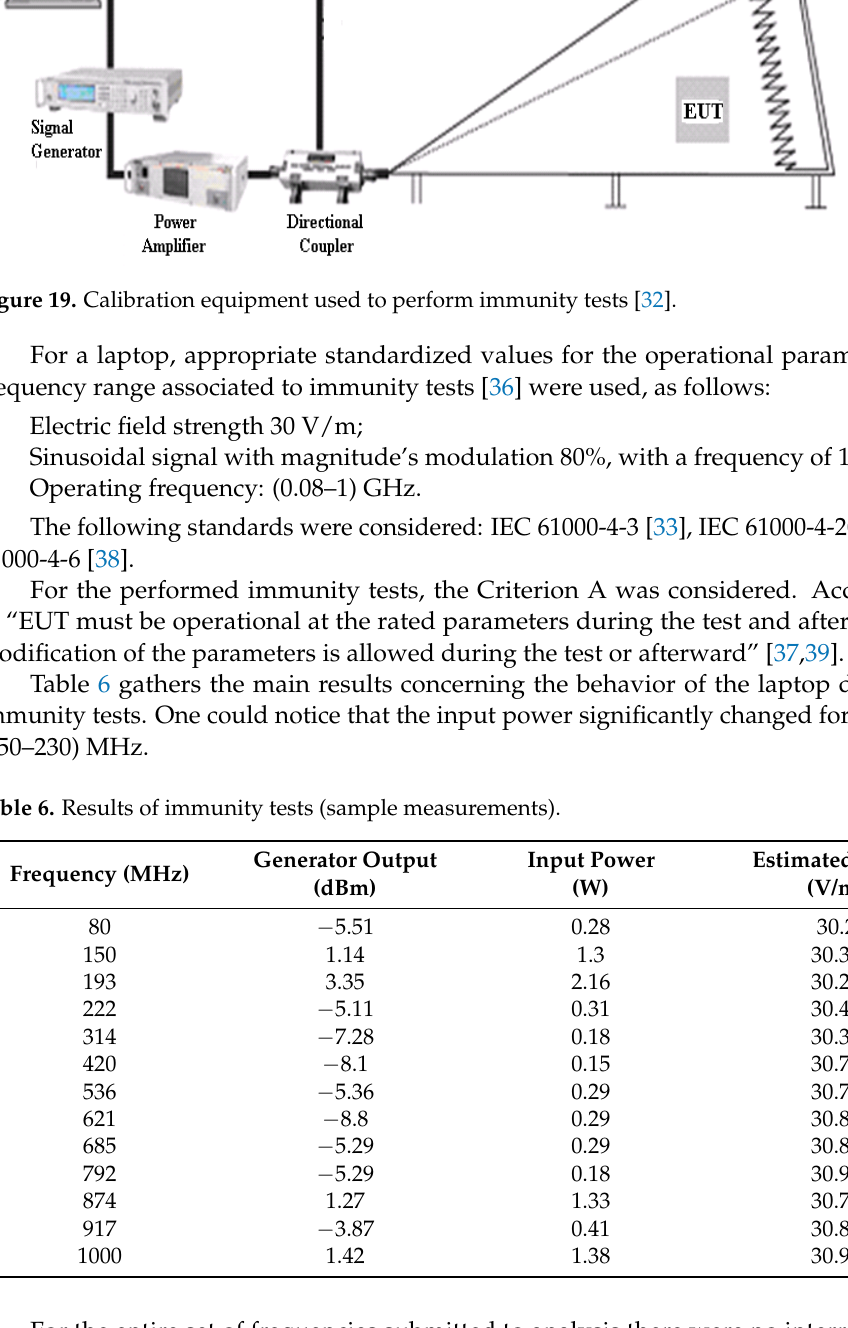
Table 6. Results of immunity tests (sample measurements).